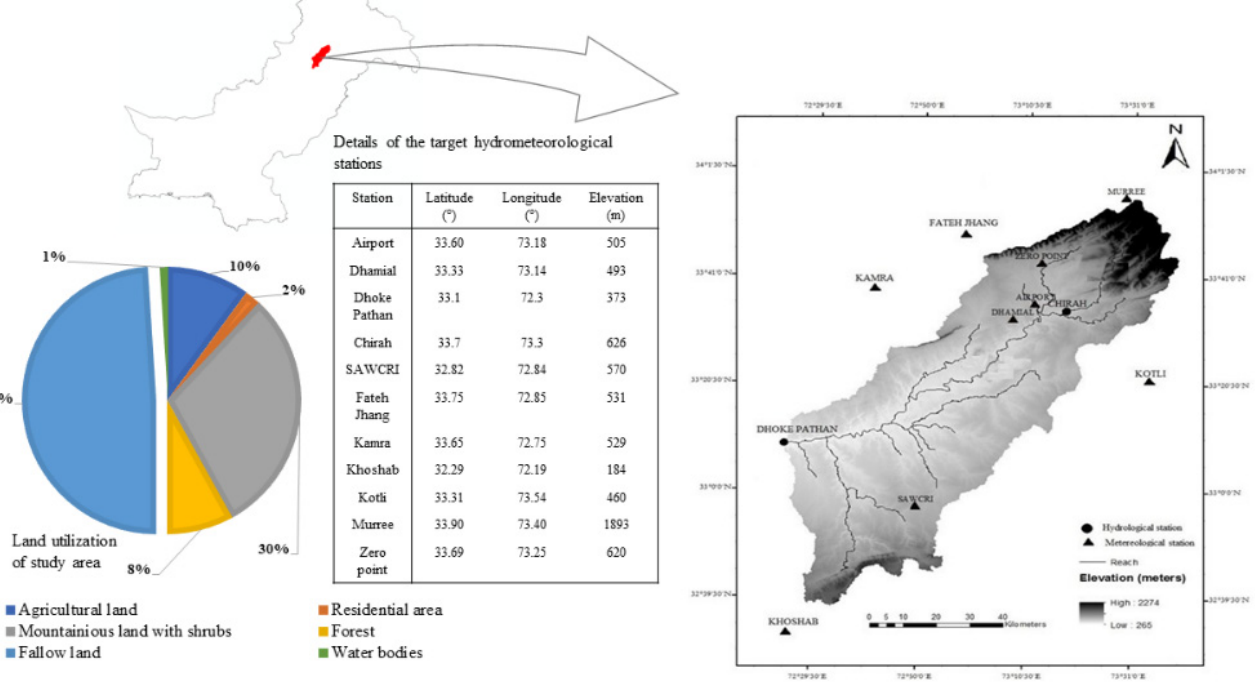
Figure 1. Study area with the locations of hydrometeorological stations and pattern of land utilizations.